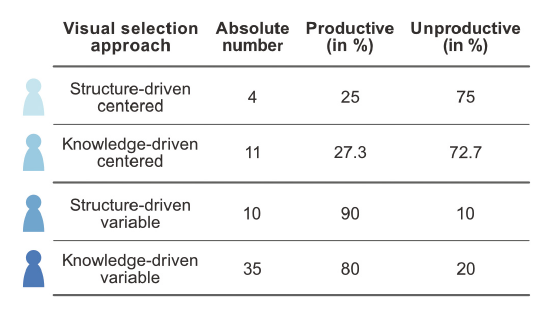
FIGURE9 Absolute distribution and success rate of the different visual selection